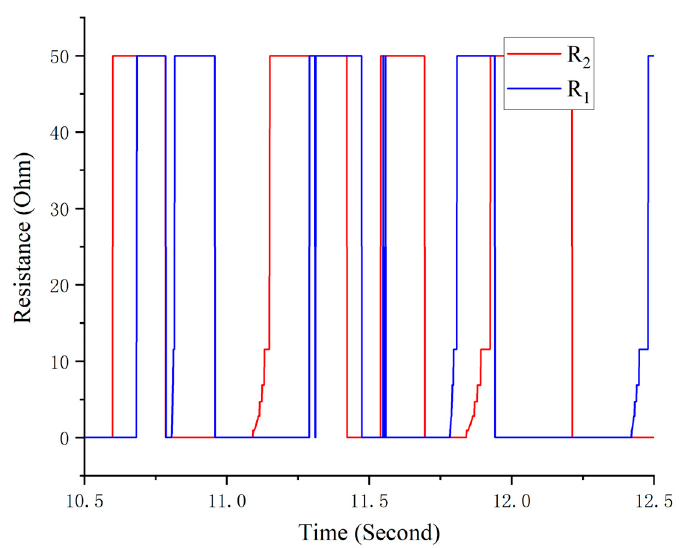
Figure 21. The resistance of VEI–VD device.